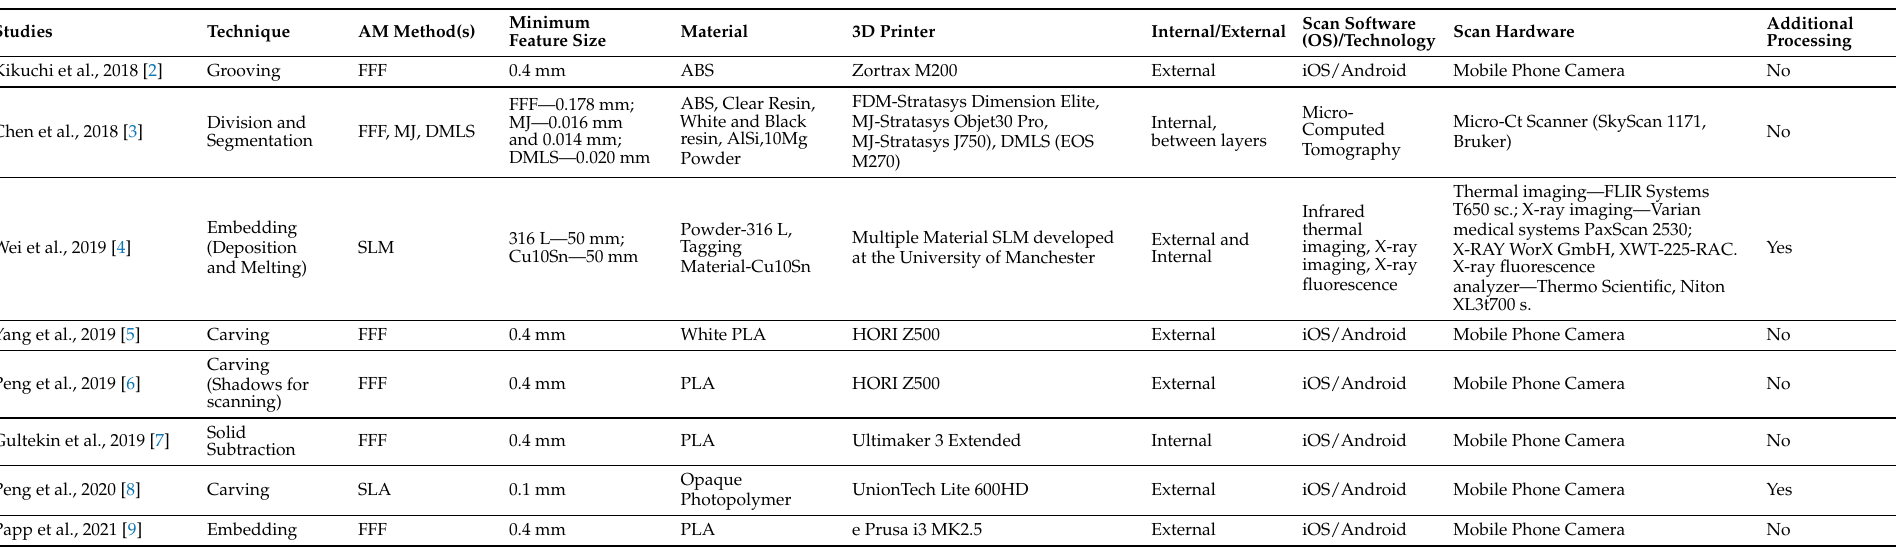
Table 1. Studies vs. 3D QR code